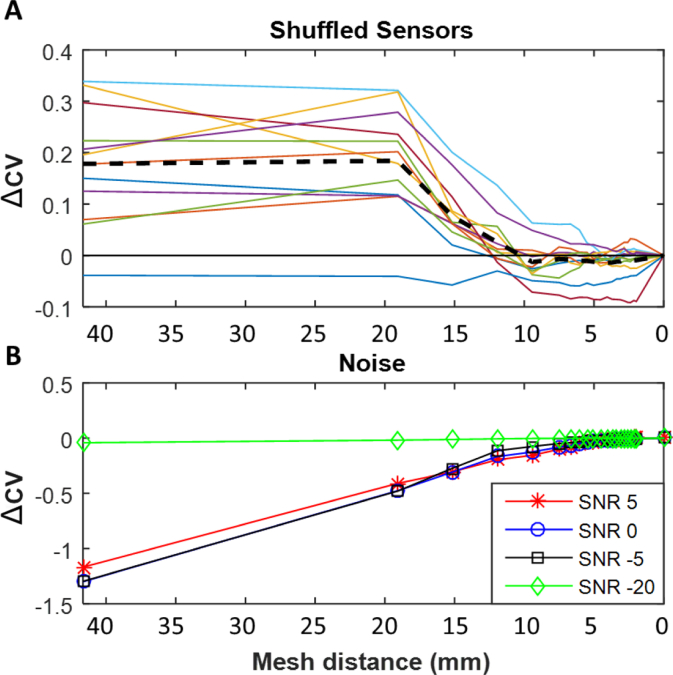
Effects of shuffling sensors (A) and replacing data with varying levels of Gaussian White noise (B). A. The relationship between the percentage of data explained through cross validation (ΔCV) of inversion (normalised to the real mesh) and increasing harmonic mesh after random shuffling of sensor labels. Note the decreasing cross validation fit with increasing mesh harmonic (increasing mesh detail) with the dashed line showing the average across all subjects. B. The relationship between (mean of all 12 subjects) ΔCV of inversion and increasing harmonic mesh after addition of Gaussian white noise across a range of noise additions (from SNR 5 to SNR -20 in decibels (dB)).